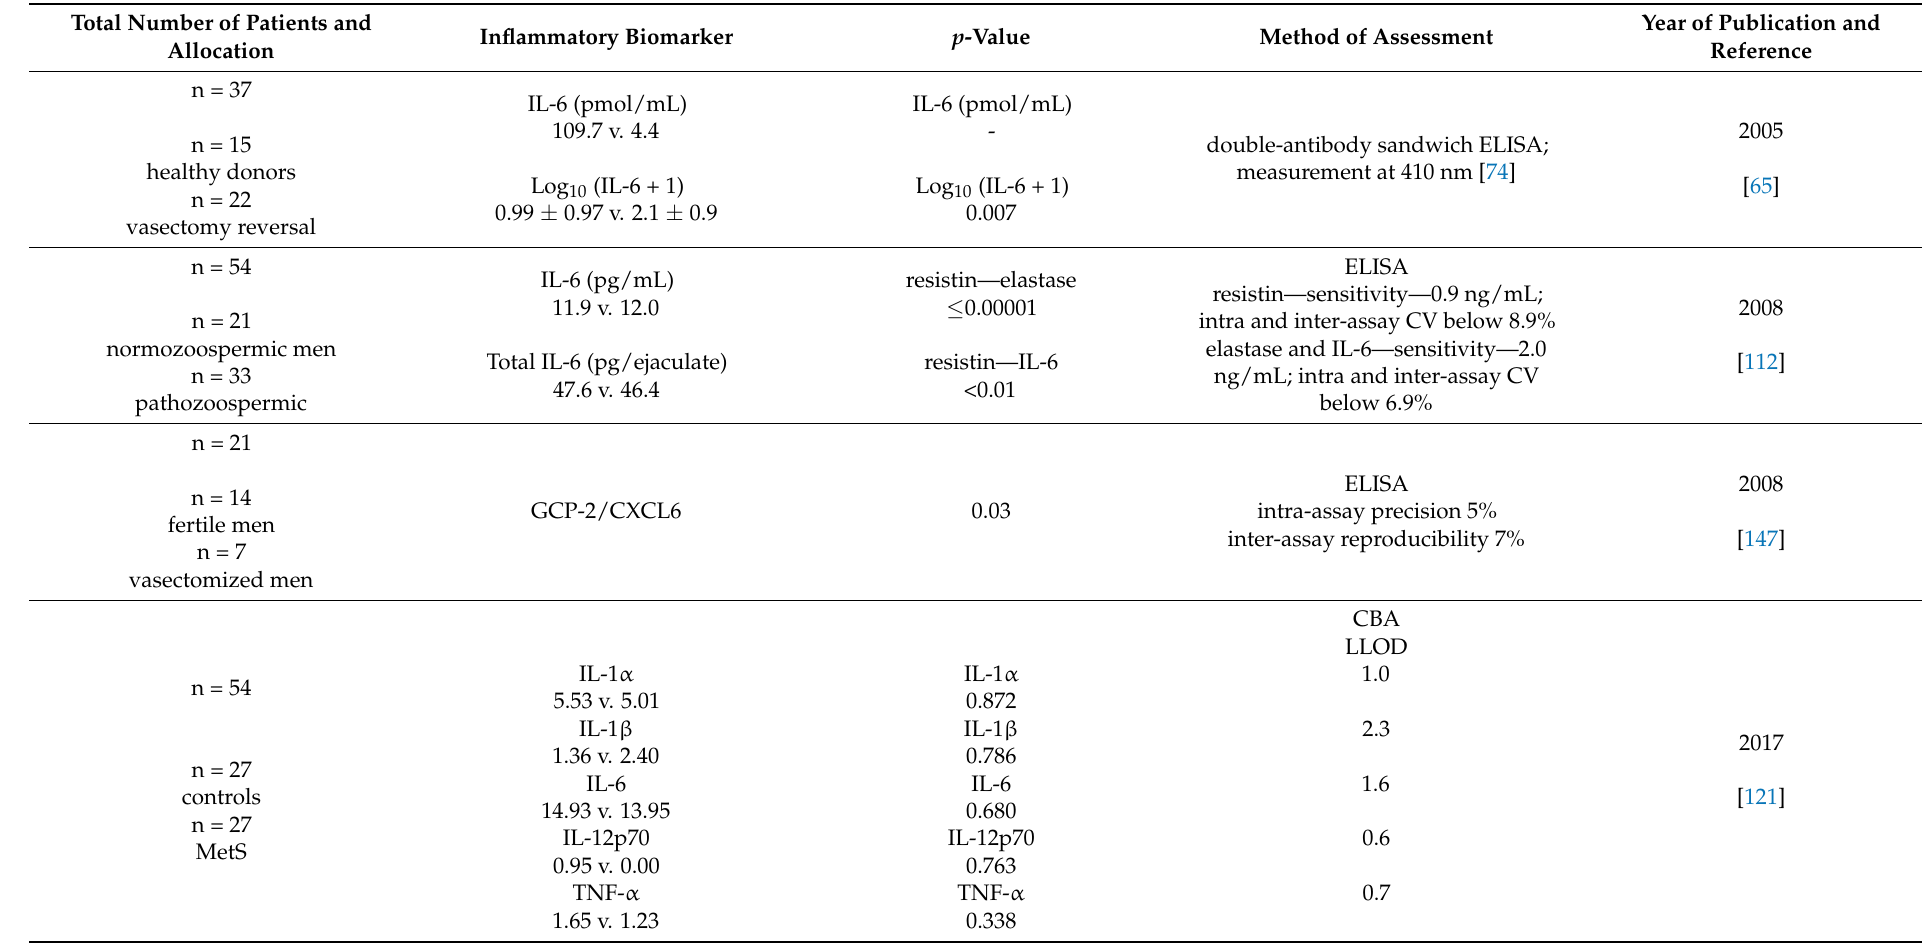
Table 3. Stratification of studies per year of publication based on design and allocation of patients with the main results that highlight inflammation in human